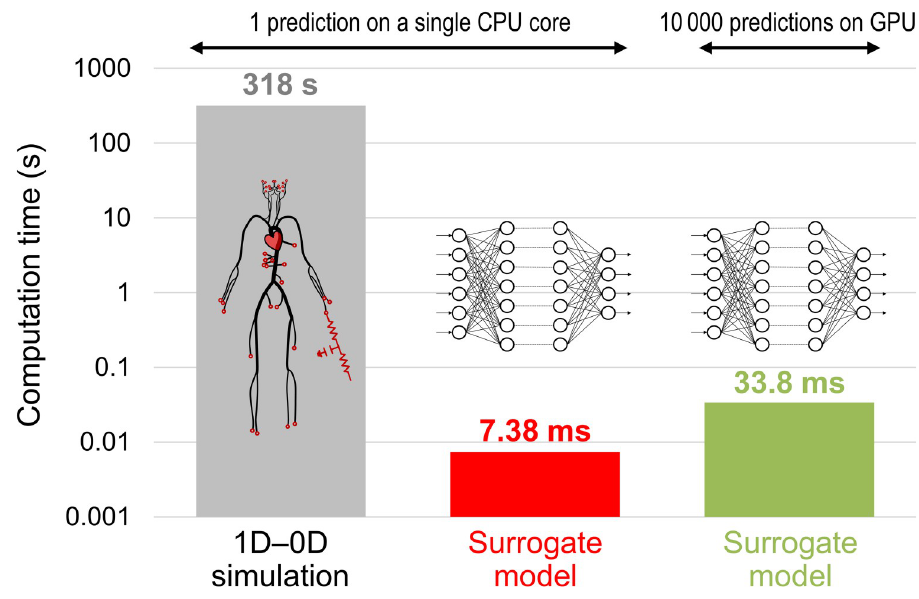
Fig 7. Comparison of the time required for prediction. Computation times for a one-dimensional–zero-dimensional (1D–0D) simulation and surrogate model on one CPU core and a surrogate model on GPU are compared.